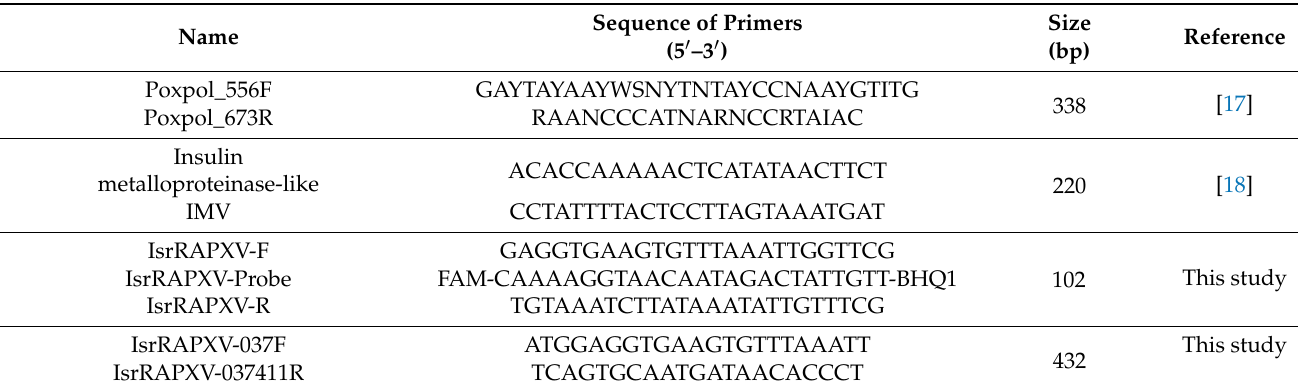
Table 2. Primers and probe used in this